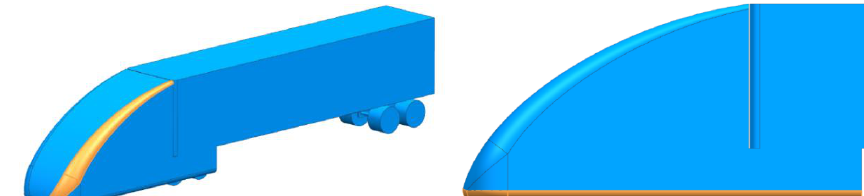
Fig. 12. Tractor side (left) and floor (right) radius changes for Concept Two - Revision A, highlighted in orange.